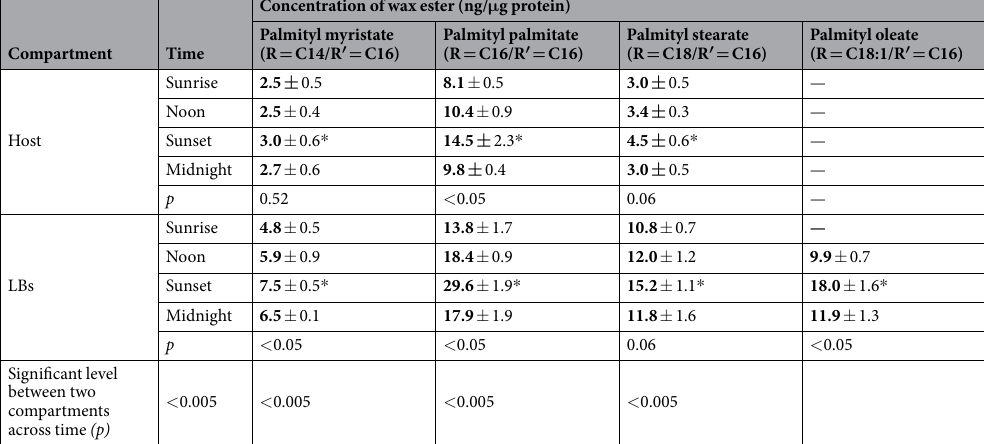
diel variation (sunrise, noon, sunset, midnight; 6.1 ± 1.0, 7.1 ± 0.6, 13.5 ± 1.1, 8.2 ± 1.3 ng/ μ g protein). SEs con- centration (Fig. 3B) increased as light intensity (sunrise to noon, 29.1 ± 1.3 to 34.1 ± 0.3 ng/ μ g protein). The main lipid species within the lipidomes of in hospite Symbiodinium (Fig. 3 and Supplementary Table S2) were TAGs (Fig. 3A), FFAs (Fig. 3B), SEs (Fig. 3C), and PLs (Fig. 3D; 60–120 ng/ μ g protein for each species). SEs concentration declined over the course of the day (sunrise to noon, 58.7 ± 0.7 to 52.4 ± 1.1 ng/ μ g protein) until sunset at which point it began to increase, reaching its highest concentration at midnight (78.7 ± 6.6 ng/ μ g protein). The most abundant Symbiodinium lipids were FFAs, and its concentration reached a peak at noon (117.1 ± 12.5 ng/ μ g protein). The variation in TAGs and PLs concentrations revealed a similar trend: highest levels at sunset (76.6 ± 1.3 and 90.0 ± 3.3 ng/ μ g protein, respectively) and lowest at midnight (28.7 ± 6.2 and 71.0 ± 0.1 ng/ μ g protein, respectively). WEs (Fig. 3E) were not detected in in hospite Symbiodinium . However, four classes of WEs varied in con- centration over time in both host gastrodermal cells and LBs (Table 1), reaching peak levels at sunset. The most abundant WE was palmityl palmitate (R = C16/R ′ = C16), which reached maximum concentrations at sun- set in host gastrodermal cells and LBs (14.5 ± 2.3 and 29.6 ± 1.9 ng/ μ g protein, respectively). Palmityl oleate (R = C18:1/R ′ = C16) was only detectable in LBs, and its concentrations at noon and sunset (the highest value) were 9.9 ± 0.7 and 18.0 ± 1.6 ng/ μ g protein, respectively. Temporal contribution of individual lipids to LB formation. We attempted to understand the LBs formation by investigating its temporal contribution of individual lipids from cellular compartments (i.e., the host cell and symbionts) over the diel cycle. PCA was used to highlight temporal differences in individual lipid spe- cies at each sampling time (see Fig. 4, Table 1 and Supplementary Tables S4–S7 and S9). PCA of TAGs (Fig. 4A) revealed an apparent clustering of host at sunset and midnight (Host 3 and 4, respectively) with LBs at sunset (LB 3) along PC1, which explained the vast majority of the variation ( > 80%). Moreover, there was also a similarity amongst Symbiodinium from noon to midnight (Sym 2, 3, and 4) and LBs along PC1. This is partially masked by the fact that these two fractions were also separated along PC2, though this PC account for only 10% of the vari- ation. In the PCA of the FA profile of SEs, the first two PCs explained 62.2% and 21.0% of the variation (Fig. 4B, 83.2% total). In particular, PCA revealed small differences at noon to midnight in the host coral gastrodermal cells (Host 2, 3, and 4), and sunset to midnight in the in hospite Symbiodinium populations (Sym 3 and 4, respec- tively). The PCA suggested that FA moieties of host and Symbiodinium SEs were similar to those of LBs during these sampling times. For FFAs (Fig. 4C), the first two PCs explained 95.4% of the total variation (PC1, 82.2%; PC2, 13.2%). Some groups clustered together along PC1, including hosts from sunrise to sunset (Host 1, 2, and 3), LBs at sunset (LB 3), and in hospite Symbiodinium at noon (Sym 2). These results indicated that the FA moieties of the host’s FFAs pool resembled those of the LBs from sunrise to sunset, whereas Symbiodinium FFAs profiles were similar to those of LBs at noon. PCA of the PLs dataset (Fig. 4D) showed a clear separation of LBs, host coral, and in hospite Symbiodinium samples, with PC1 and PC2 explaining 68.4% and 21.4% of the total variation, respectively. Host coral samples exhibited higher variation among individuals in the score plots than the Symbiodinium samples. Moreover, PCA revealed significant differences in PLs FAs composition among host cells, LBs, and dinoflagellates, and no over- laps were detected between host cells and LBs. PCA of the WEs profile showed that sunrise of LBs and all four